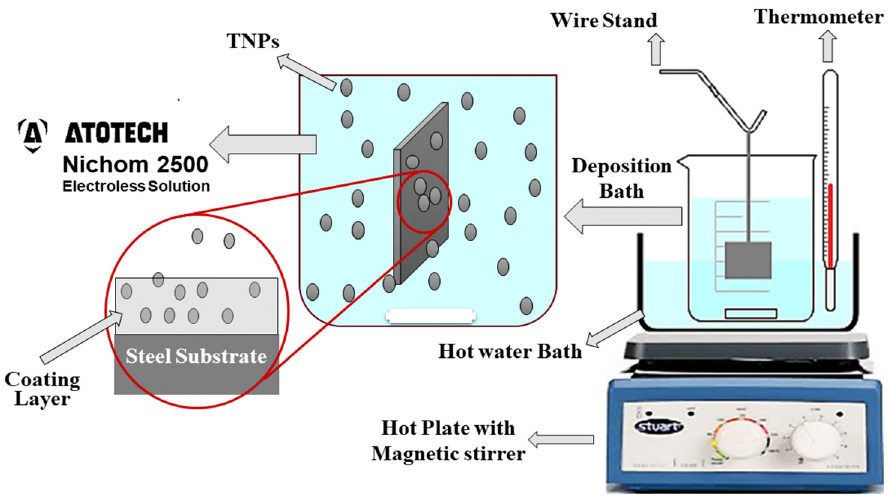
Figure 1. The schematic diagram for the electroless deposition processing.